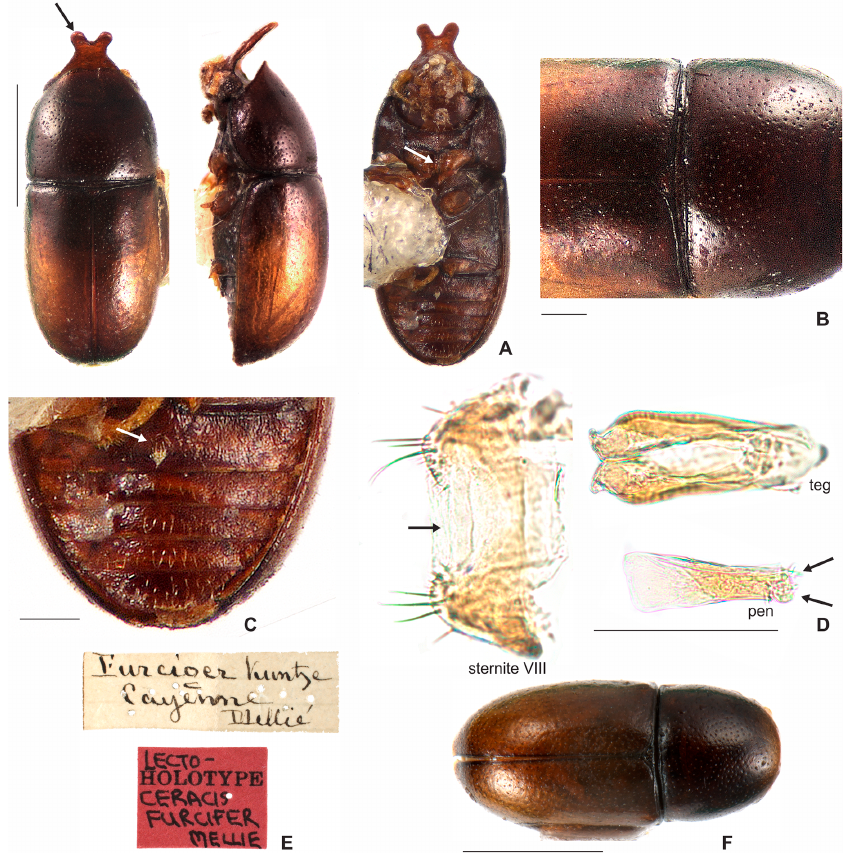
Figure 7. Ceracis furcifer Mellié . A − C Male lectotype, ( A ) dorsal, lateral and ventral views, respectively. Horn apex with two conspicuous rounded lobes (black arrow); thin prosternal process (white arrow), ( B ) pronotal punctation, ( C ) first abdominal ventrite with a sex patch at centre (white arrow), ( D ) male terminalia in a topotype, showing sternite VIII with a deep concave emargination at middle (black arrow), tegmen (teg), penis (pen) with the basal edge blunt (black arrows), ( E ) labels of the lectotype deposited in the Muséum d’Histoire Naturelle, MHNG (Géneve, Switzerland) , ( F ) female plesiotype from Manaus (AM, Brazil). Scale bars: A = 0.5 mm, B − D = 0.1 mm, F = 0.5 mm.